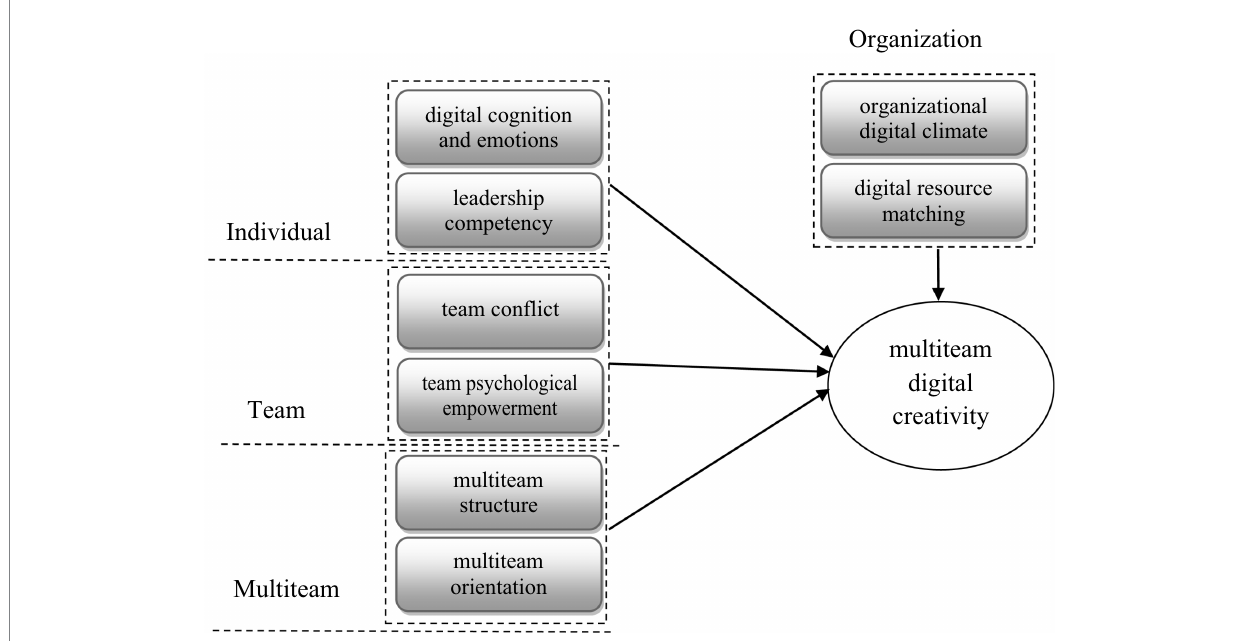
FIGURE 1 Frame of the factors influencing MTDC in the transition